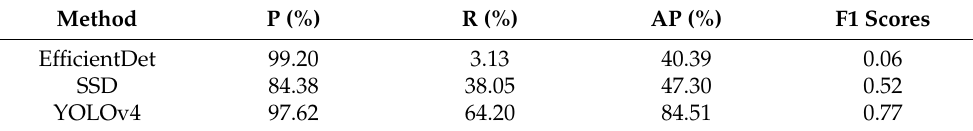
Table 2. Accuracy evaluation of each model based on the whole testing dataset.